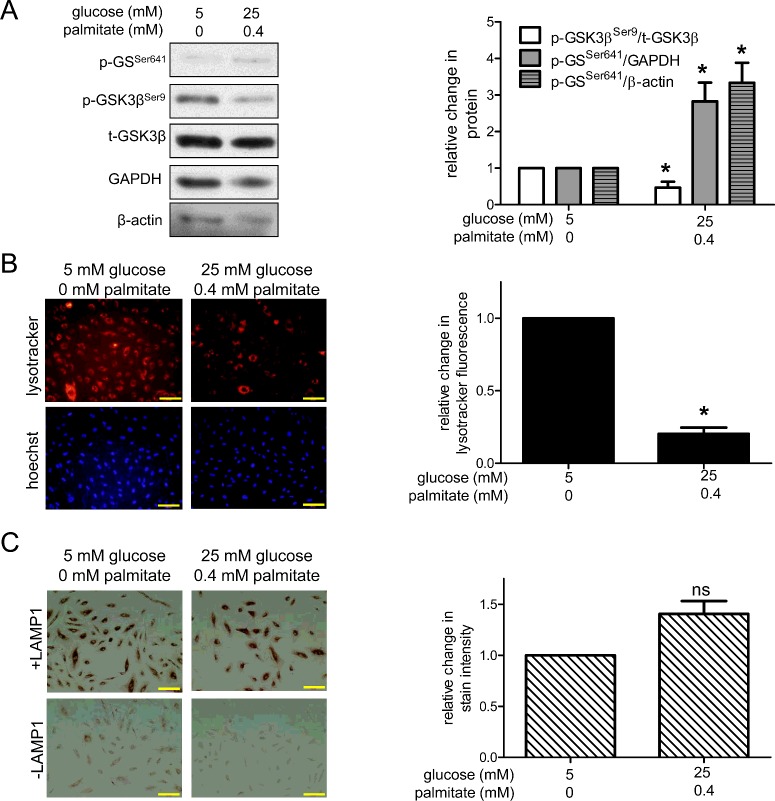
Excess nutrients increase GSK3β activity and decrease lysosome acidification(A) HAECs incubated in excess nutrient conditions have a decreased ratio of inhibitory p-GSK3βSer9/t-GSK3β protein and increased protein levels of p-GSSer641, a downstream target of GSK3β (GAPDH n=4; β-actin n=3). (B) Exposure to excess nutrients decreased lysotracker staining (n=7). (C) Excess nutrients did not decrease LAMP1 protein levels (n=5). * indicates P<0.05 by Student's t test compared with control conditions. For (B) and (C), bar=100 μm.